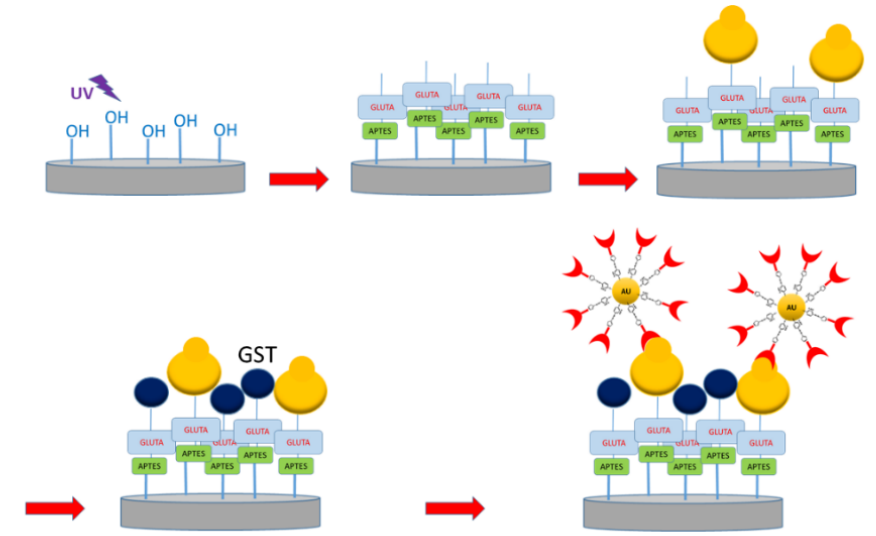
Figure 5. Sketch of the main steps followed for the substrate functionalization. An UV ray treatment to increase the amount of silanol groups is followed by incubation with APTES and GLUTA and then by a functionalization with the biomolecules. Unreacted sites were blocked with GST. Finally, the substrate is incubated with the probe (4-ATP-NP-pro) (see also the text).